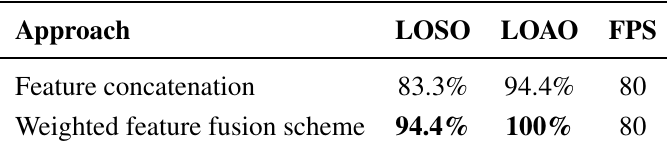
Table 8. Cross-validation results obtained on our multi-view depth